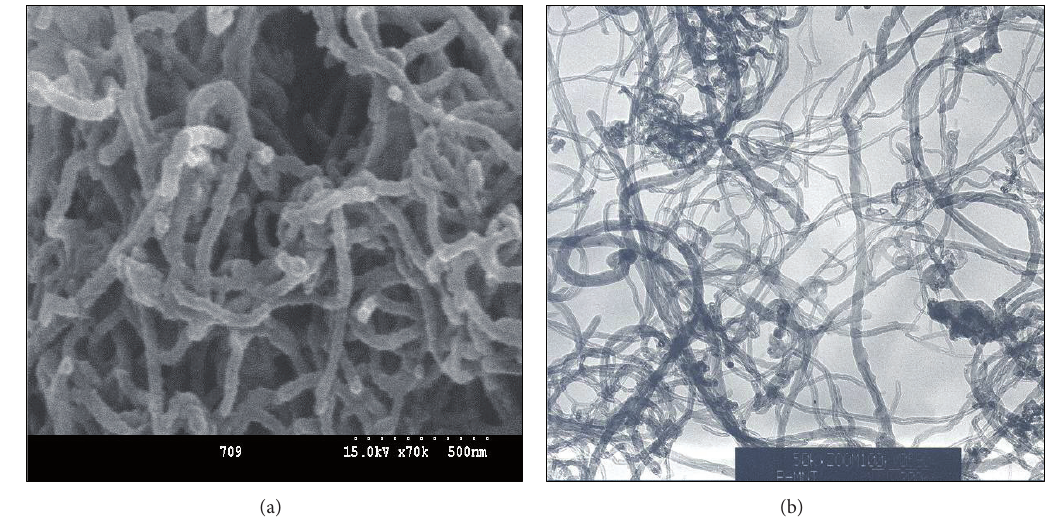
F 1: (a) FE-SEM and (b) TEM images of MWNT-PAni